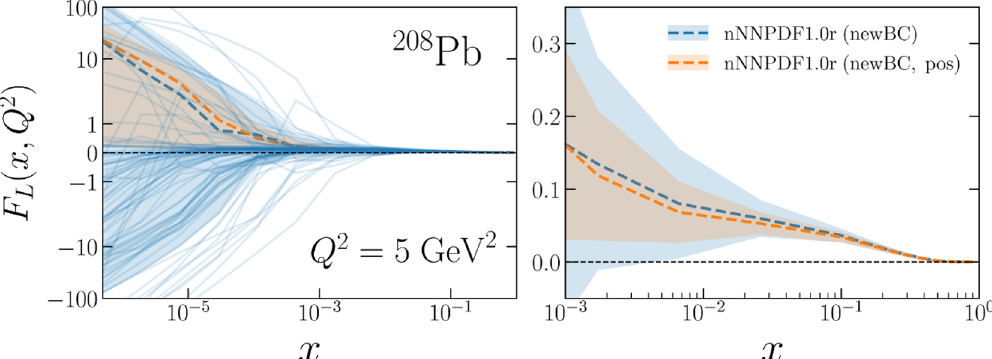
Figure 17 . The longitudinal structure function F L ( x; Q 2 ) at the positivity scale Q 2 = 5 GeV. We compare the predictions of the nNNPDF1.0r(newBC) (cid:12)ts with and without the cross-section positivity constraint imposed. We show the extrapolation (left) and the data (right) regions, in the former case displaying also the predictions from the individual replicas in the nNNPDF1.0r(newBC) (cid:12)t that do not satisfy the positivity